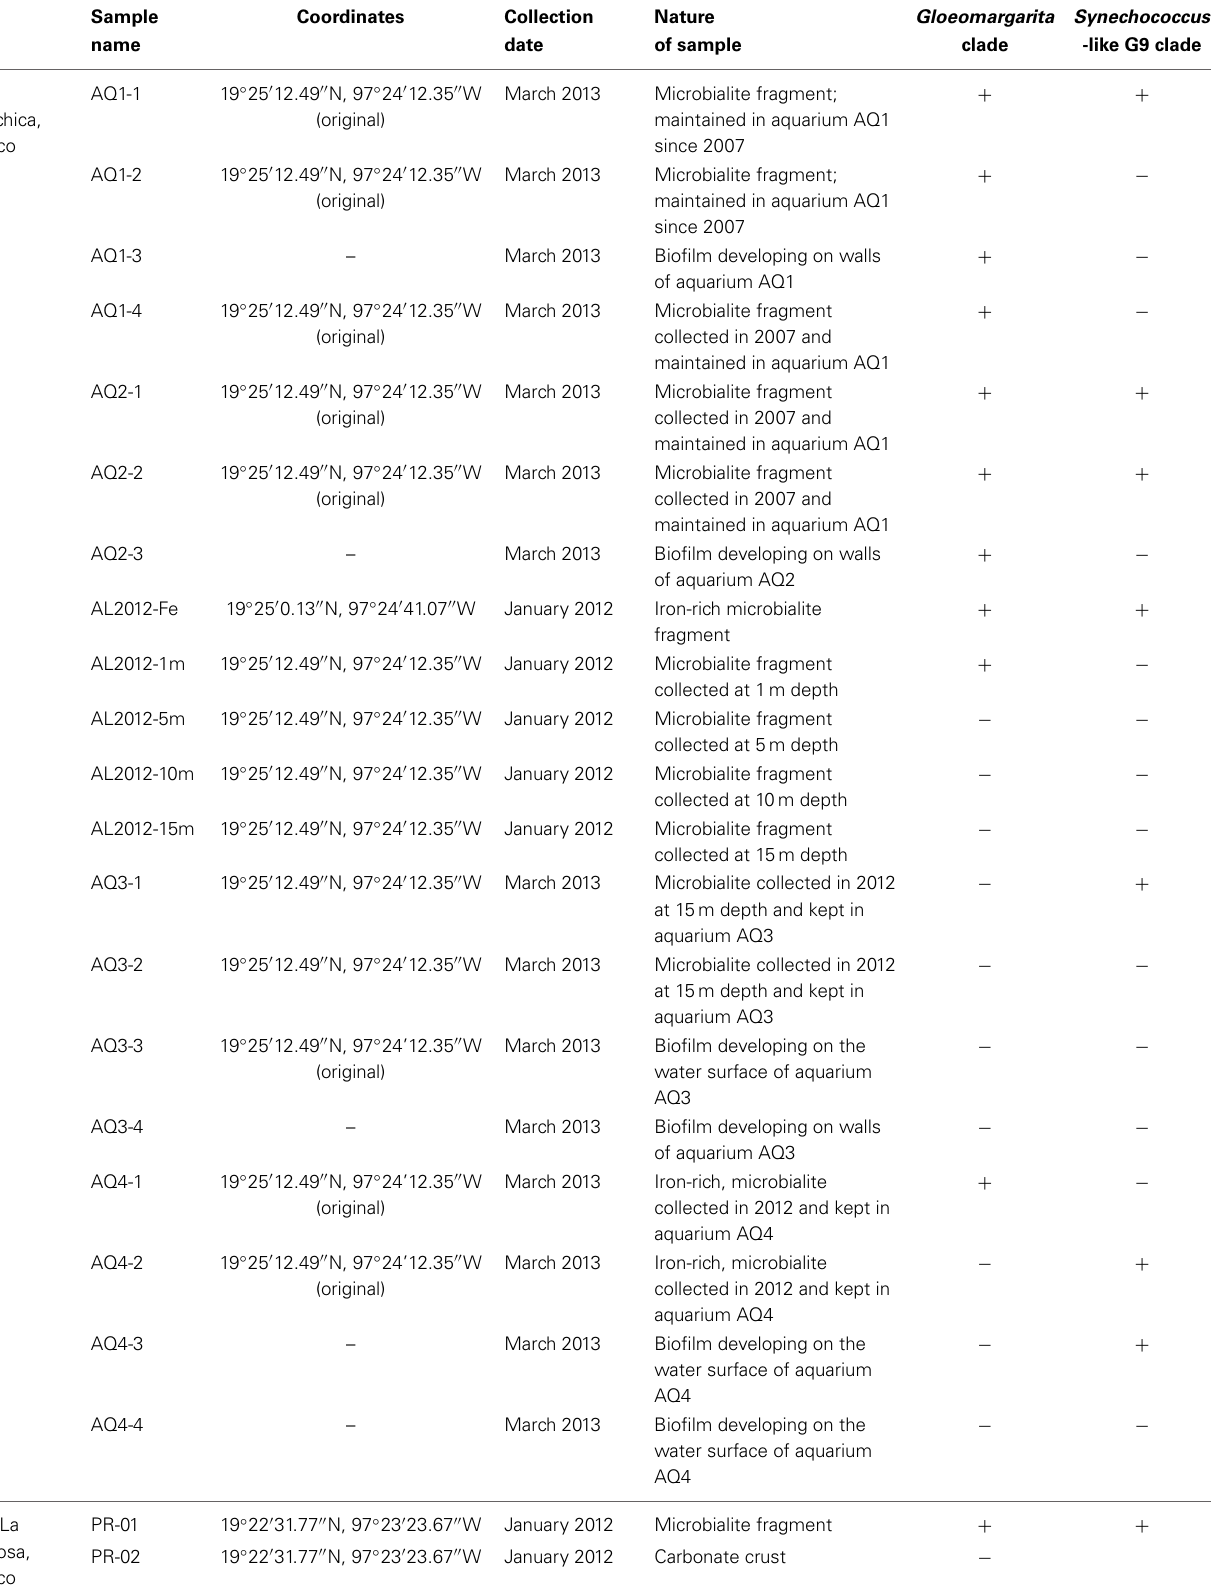
Table 1 | Samples analyzed for the presence of intracellularly calcifying cyanobacterial clades.